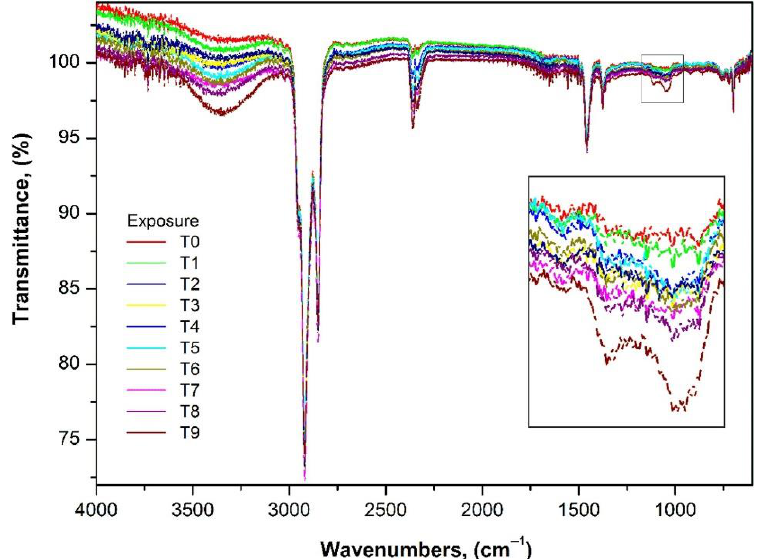
Figure 1. Fourier transform infrared (FTIR) spectra in the range of 4000–400 cm −1 of exposure time of styrene-ethylene-butadiene-styrene (SEBS).